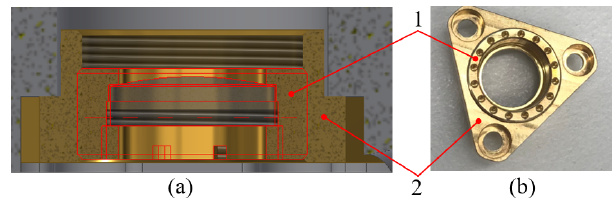
Figure 5. Photograph of the MAFM head integrated into